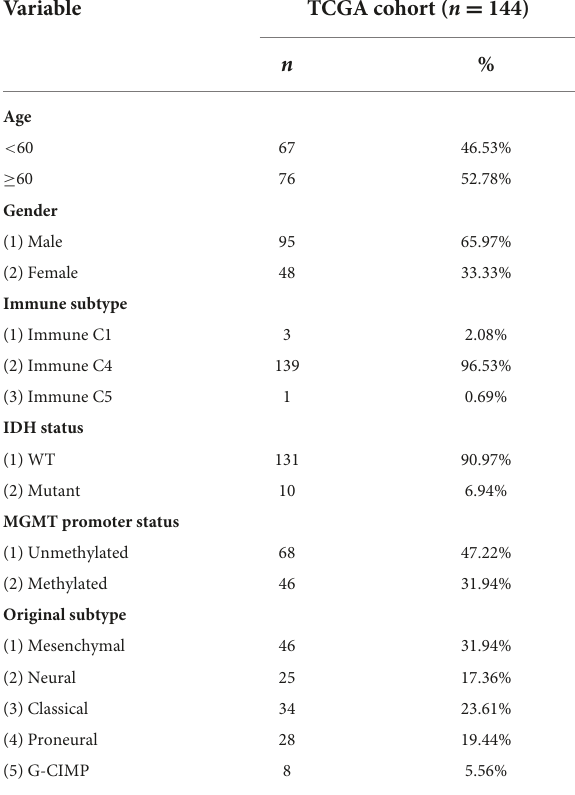
TABLE 1 TCGA patient information included in the